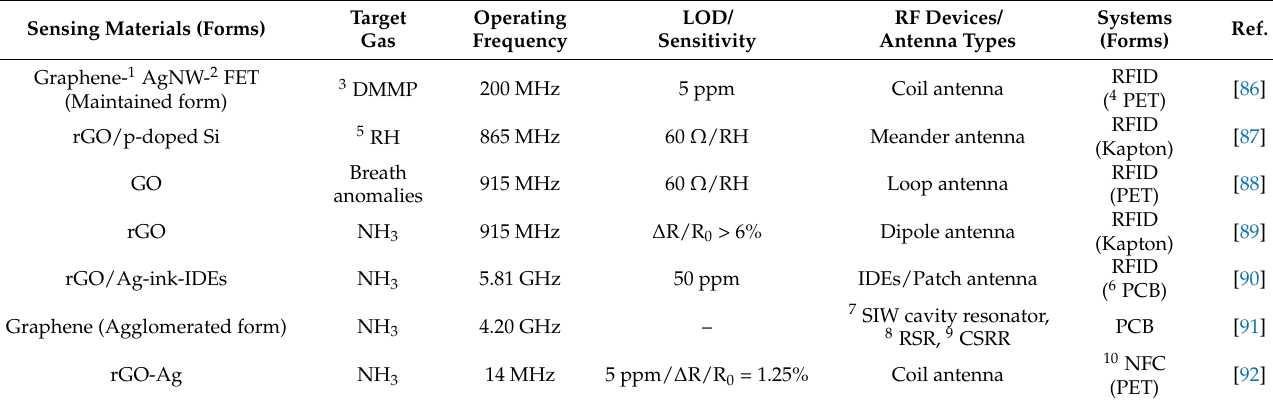
Table 4. Graphene, GO, and rGO-based RF gas sensors for wireless gas sensing platform. Sensing Materials